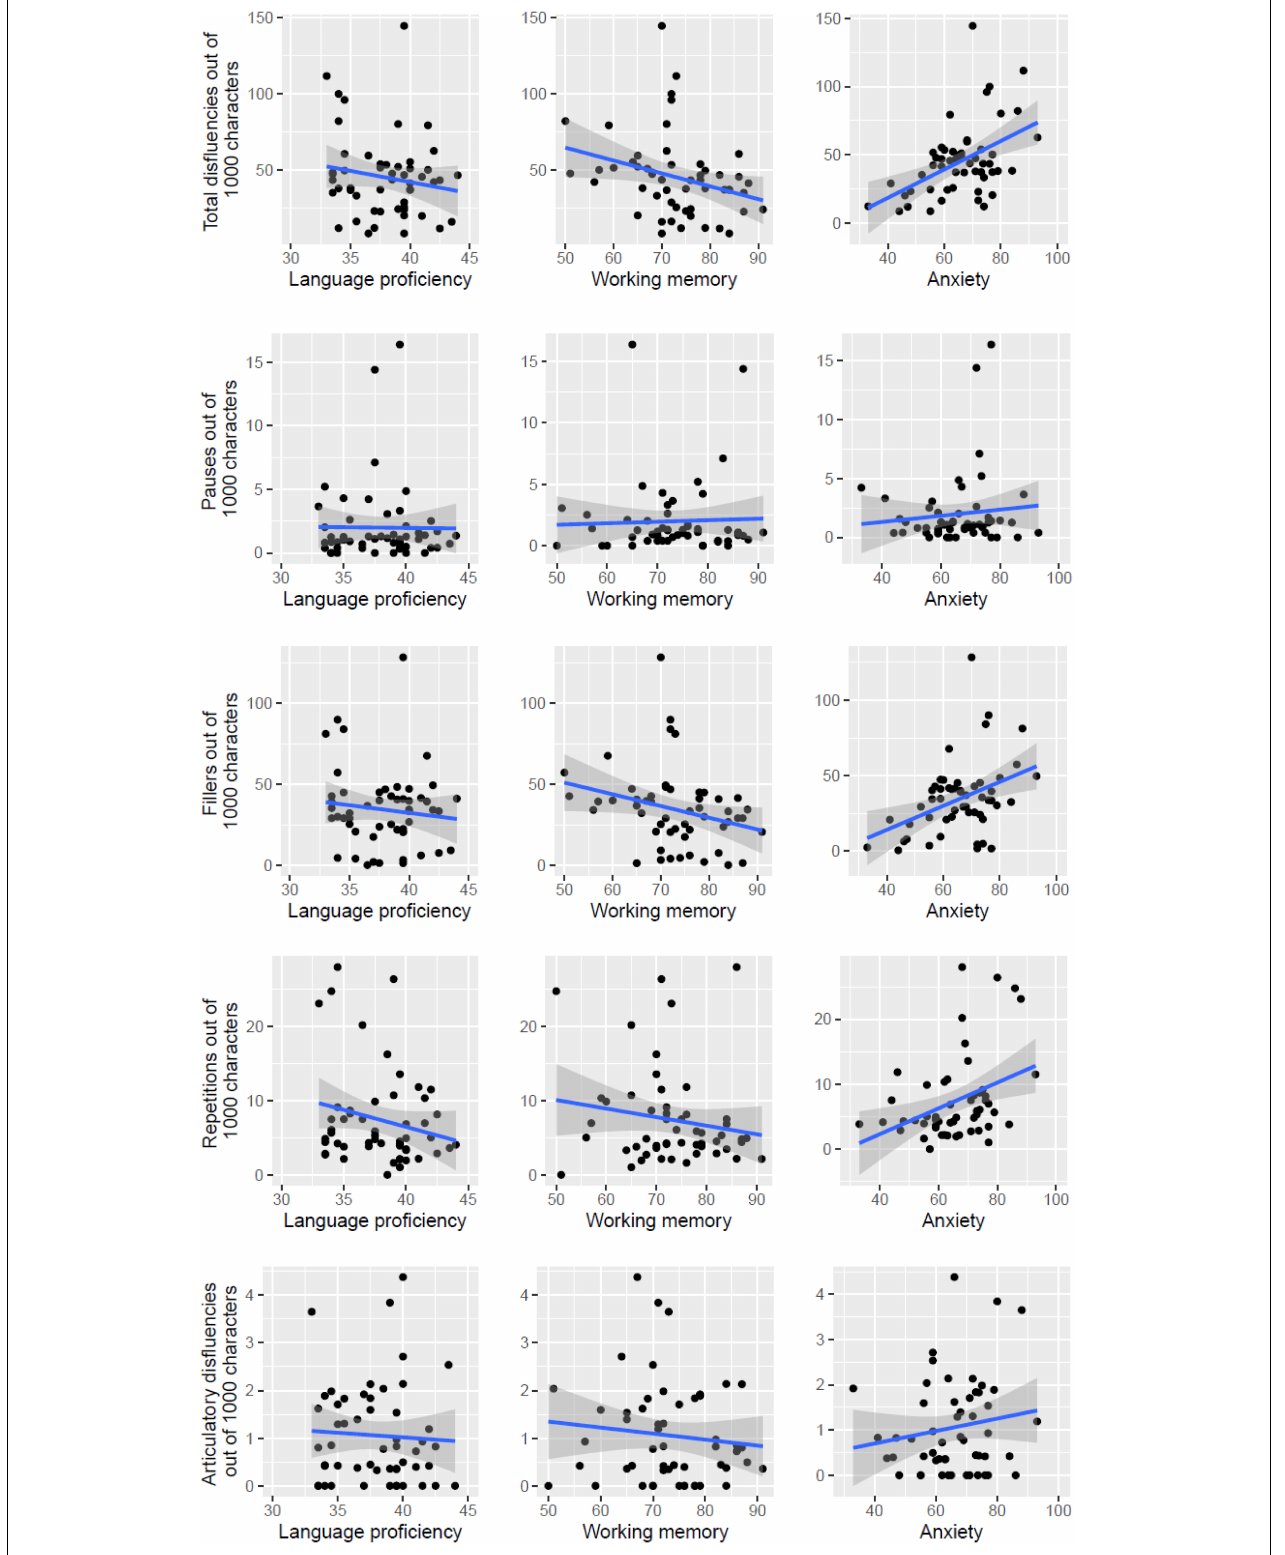
FIGURE 1 | Total disfluencies, pauses, fillers, repetitions, and articulatory disfluencies as a function of language proficiency, working memory, and anxiety.